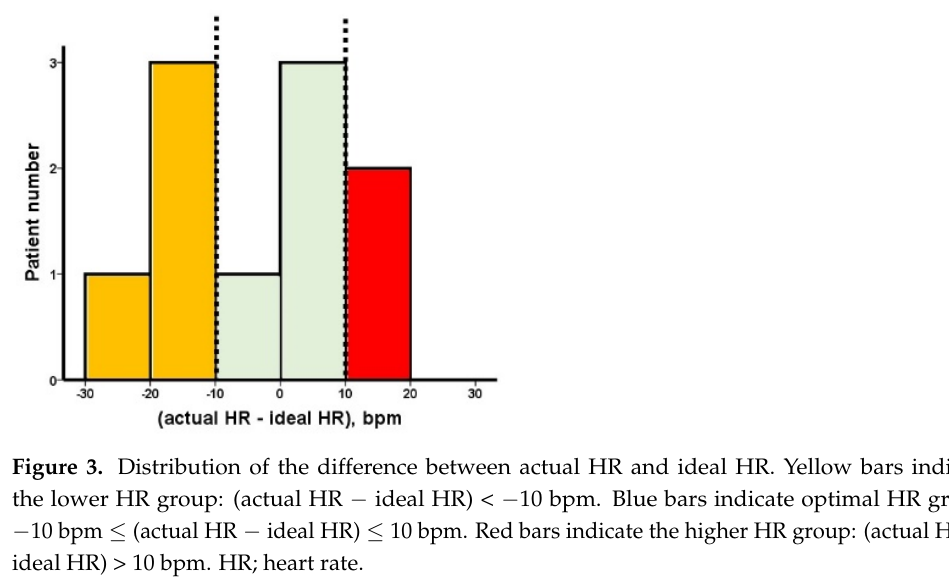
Figure 4. The incidence rate of primary endpoints stratified by the HR difference. The lower HR group: (actual HR − ideal HR) < − 10 bpm; the optimal HR group: − 10 bpm ≤ (actual HR-ideal HR) ≤ 10 bpm; the higher HR group: (actual HR − ideal HR) > 10 bpm. HR, heart rate . 3.6. Tafamidis and Clinical Events Of eight patients with transthyretin amyloidosis, 6 patients (75%) took tafamidis. The distribution of tafamidis use among the three groups was not likely to be different (three